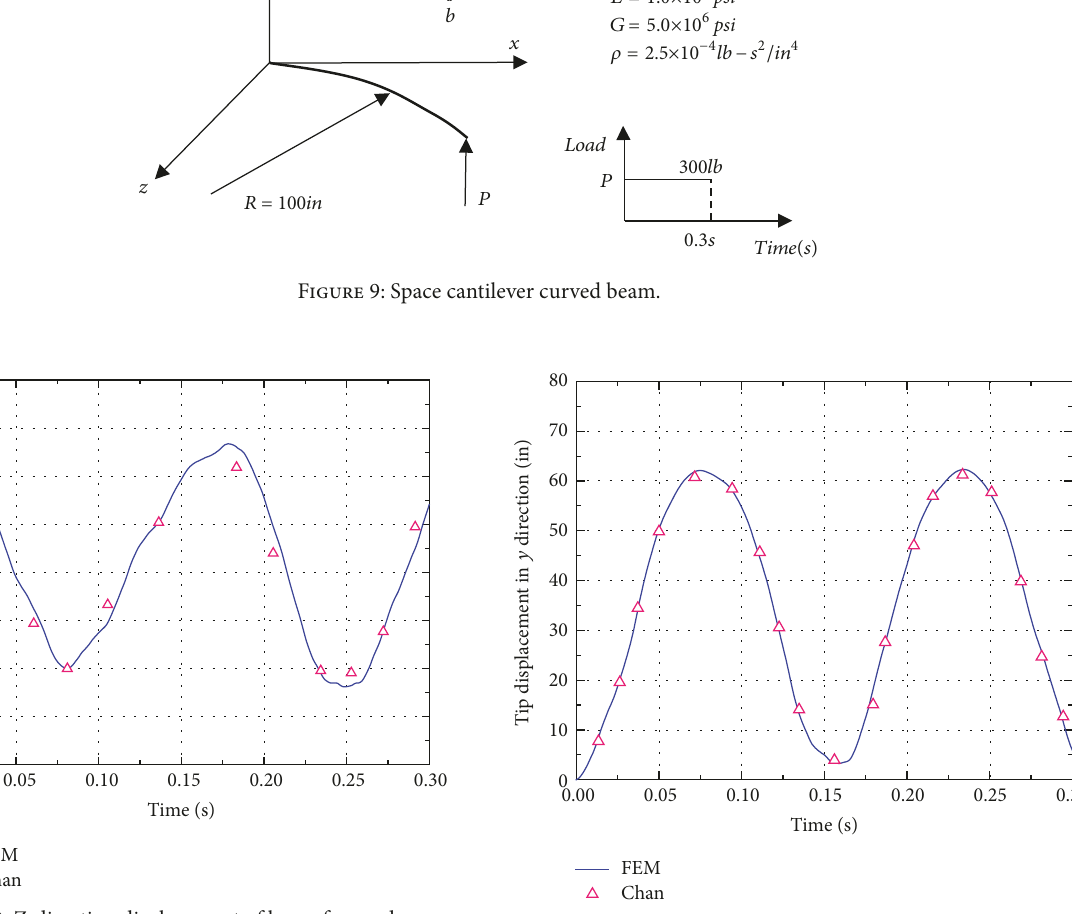
Figure 12: Y-direction displacement of beam free